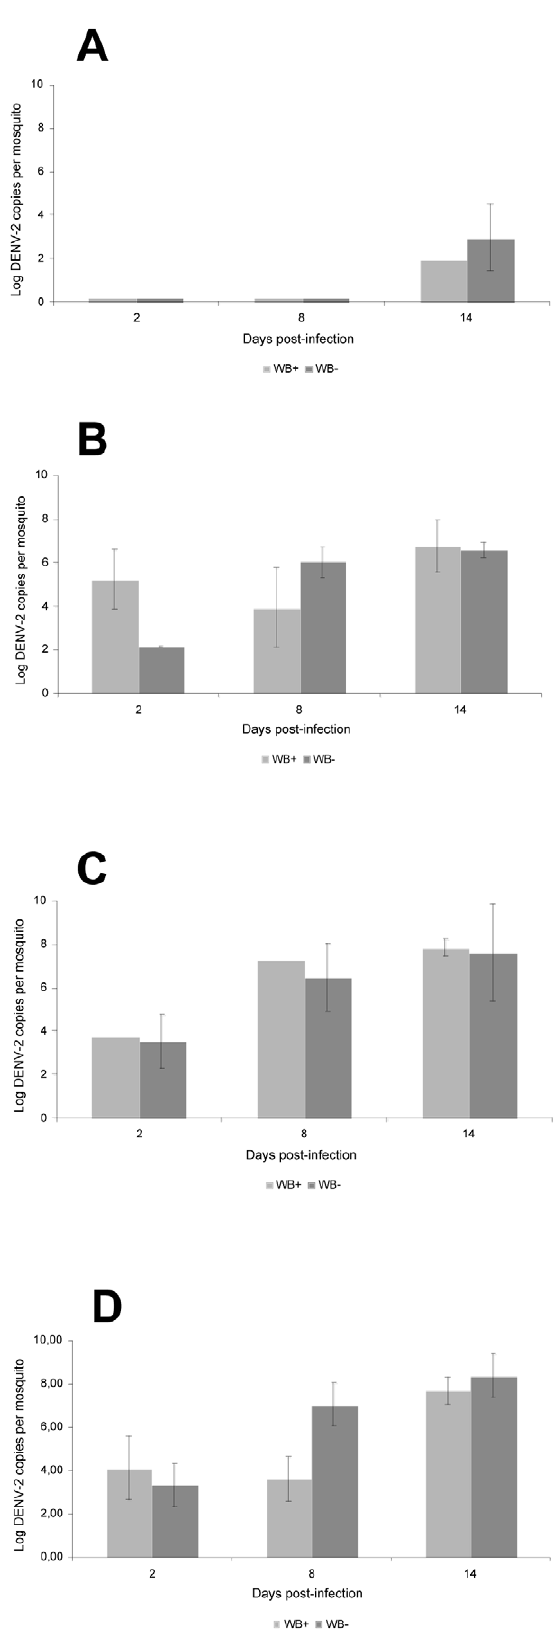
Figure 2. Viral loads in Wolbachia -infected and Wolbachia - uninfected Ae.albopictus after DENV-2 blood-meals provided at different titers. Mosquitoes were exposed to a DENV-2 blood-meal provided at four viral titers, 10 4 (A), 10 5 (B), 10 6 (C) and 10 7 (D) FFU/mL. At days 2, 8 and 14 pi, 4–9 mosquitoes were killed for RNA extraction and the number of DENV-2 genome copies was determined by qRT-PCR using primers targeting the C gene. Error bars indicate standard errors. Significance was determined using the Mann-Whitney test (p ,